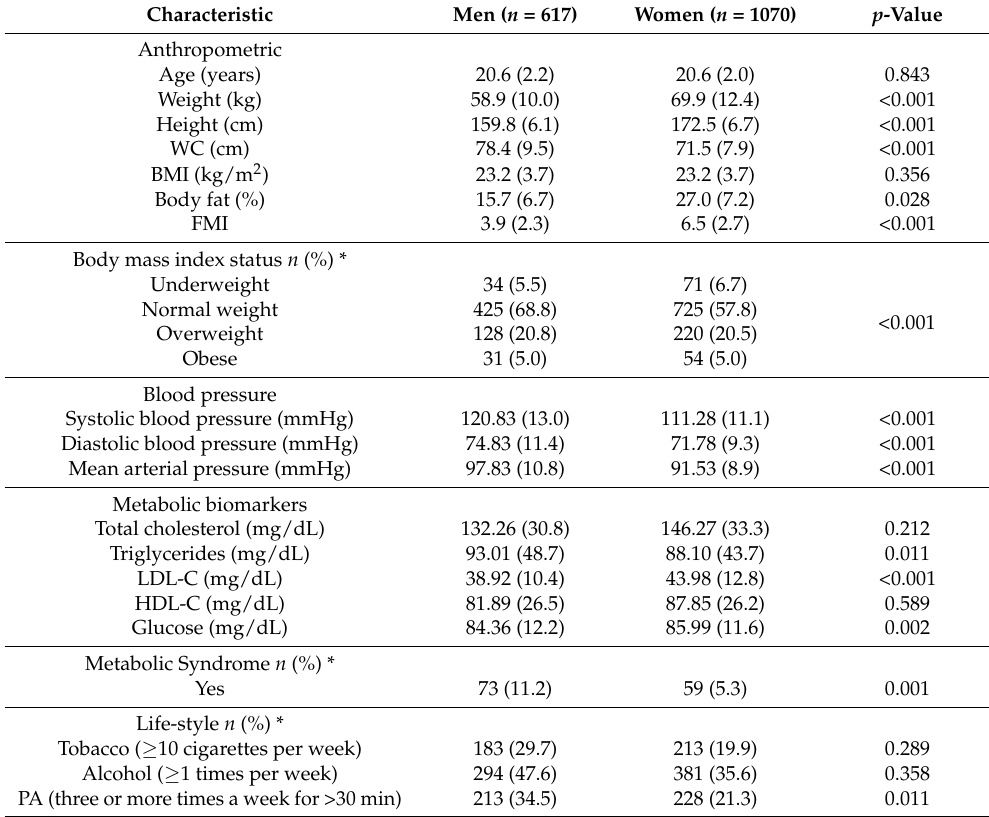
Table 1. Characteristics among a sample of college students from Colombia (mean (SD) or frequency